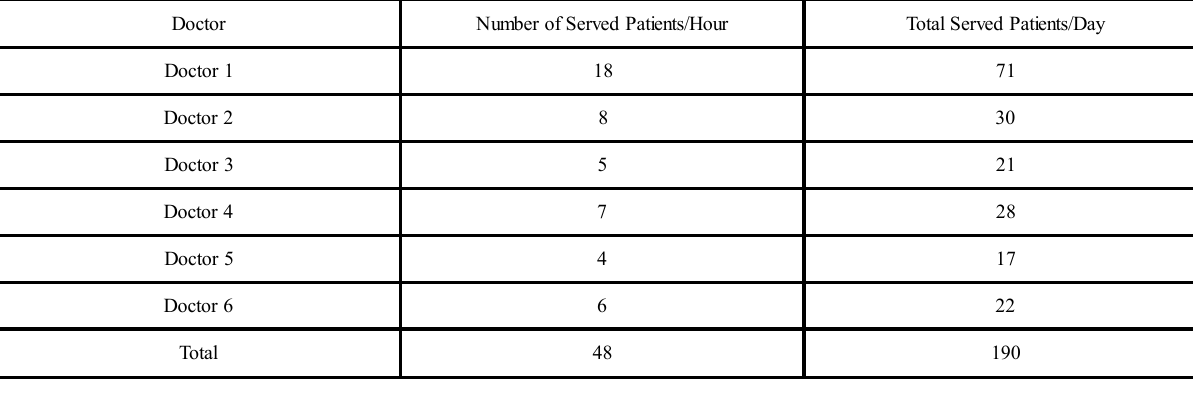
TABLE 3. PATIENTS SERVED/HR AND PER DAY BY THE DOCTORS